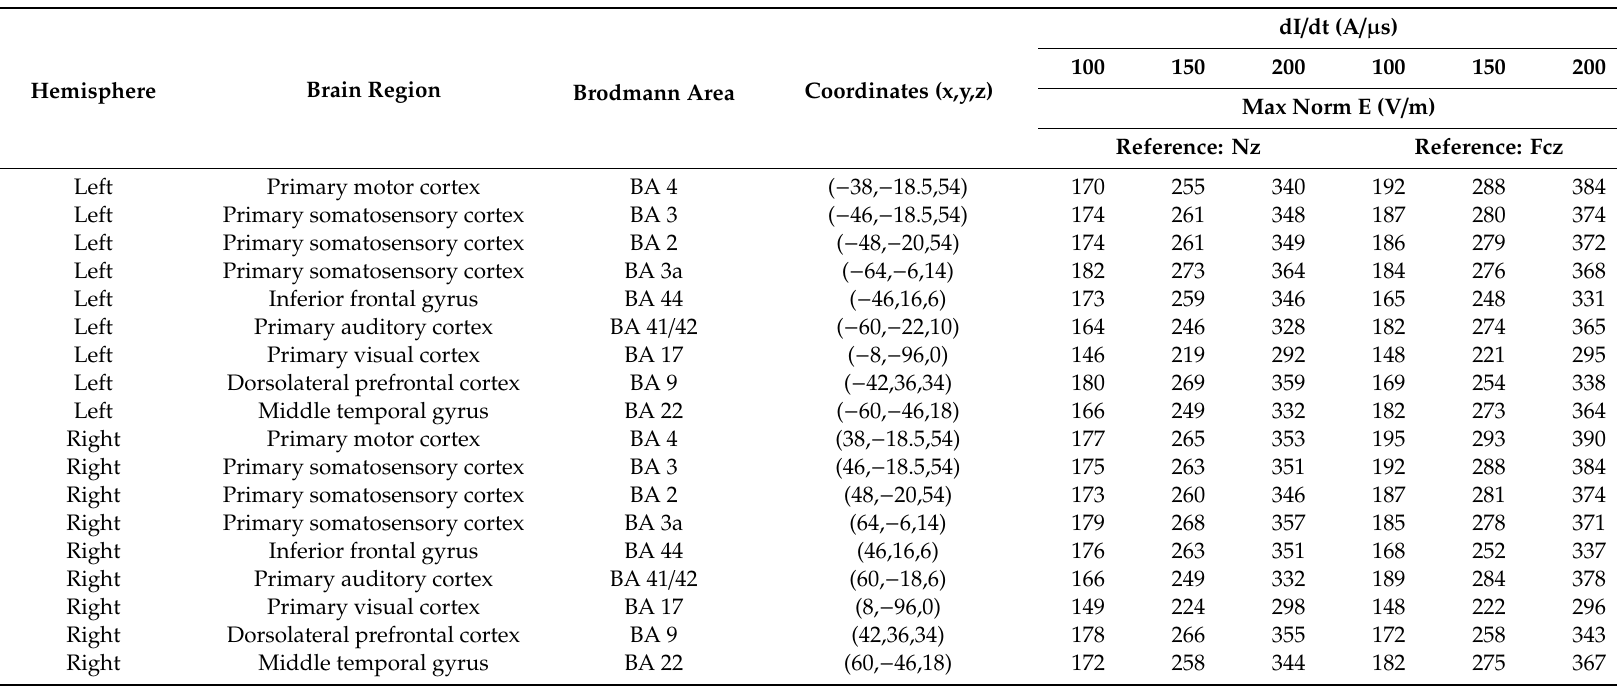
Table 1. Simulated induced E-fields for the brain areas in left and right hemispheres with the coil pointing to directions Nz and FCz for di ff erent intensities of TMS. dI / dt (A / µ s) 100 150 200 100 150 200 Hemisphere Brain Region Brodmann Area Coordinates (x,y,z) Max Norm E (V / m) Reference: Nz Reference: Fcz Left Primary motor cortex BA 4 ( − 38, − 18.5,54) 170 255 340 192 288 384 Left Primary somatosensory cortex BA 3 ( − 46, − 18.5,54) 174 261 348 187 280 374 Left Primary somatosensory cortex BA 2 ( − 48, − 20,54) 174 261 349 186 279 372 Left Primary somatosensory cortex BA 3a ( − 64, − 6,14) 182 273 364 184 276 368 Left Inferior frontal gyrus BA 44 ( − 46,16,6) 173 259 346 165 248 331 Left Primary auditory cortex BA 41 / 42 ( − 60, − 22,10) 164 246 328 182 274 365 Left Primary visual cortex BA 17 ( − 8, − 96,0) 146 219 292 148 221 295 Left Dorsolateral prefrontal cortex BA 9 ( − 42,36,34) 180 269 359 169 254 338 Left Middle temporal gyrus BA 22 ( − 60, − 46,18) 166 249 332 182 273 364 Right Primary motor cortex BA 4 (38, − 18.5,54) 177 265 353 195 293 390 Right Primary somatosensory cortex BA 3 (46, − 18.5,54) 175 263 351 192 288 384 Right Primary somatosensory cortex BA 2 (48, − 20,54) 173 260 346 187 281 374 Right Primary somatosensory cortex BA 3a (64, − 6,14) 179 268 357 185 278 371 Right Inferior frontal gyrus BA 44 (46,16,6) 176 263 351 168 252 337 Right Primary auditory cortex BA 41 / 42 (60, − 18,6) 166 249 332 189 284 378 Right Primary visual cortex BA 17 (8, − 96,0) 149 224 298 148 222 296 Right Dorsolateral prefrontal cortex BA 9 (42,36,34) 178 266 355 172 258 343 Right Middle temporal gyrus BA 22 (60, − 46,18) 172 258 344 182 275